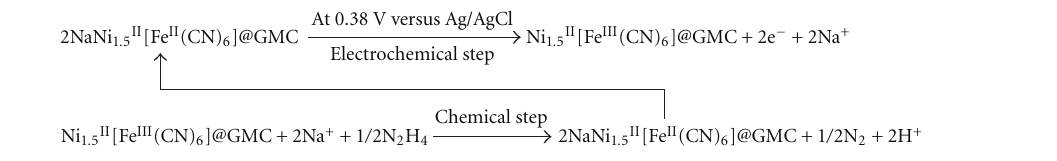
NiHCFe@GMC is 1.97%. Calculated detection limit